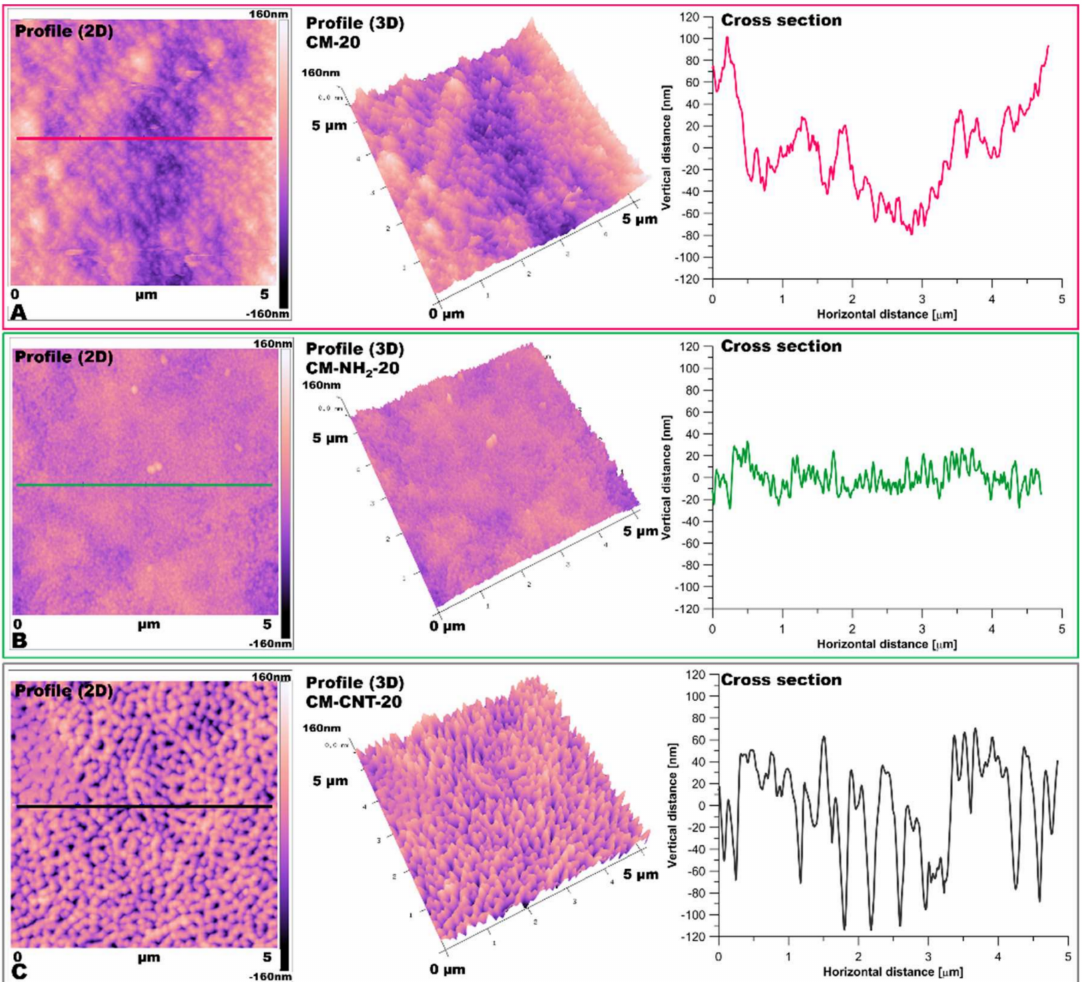
Figure 8. AFM imaging of membrane 2D and 3D topography and cross-section of samples: ( A ) pristine (CM-20); ( B ) after first stage of functionalization with amine groups (CM-NH 2 -20); ( C ) after second stage of functionalization with CNT